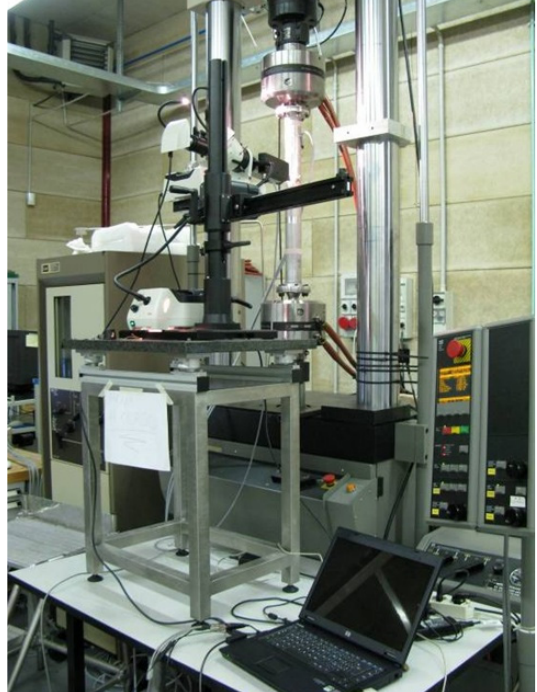
Figura 10: Strumentazione utilizzata per monitorare l’avanzamento delle cricche.